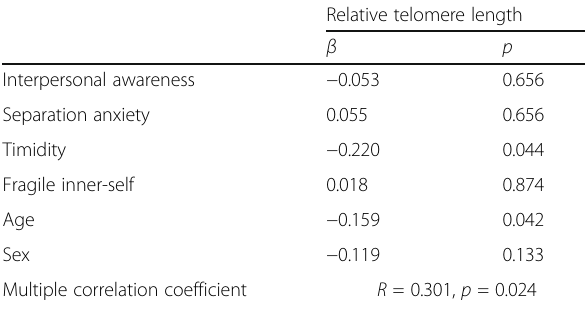
Table 3 Effects of the 4 sub-scale scores of the IPSM, age, and sex on relative telomere length